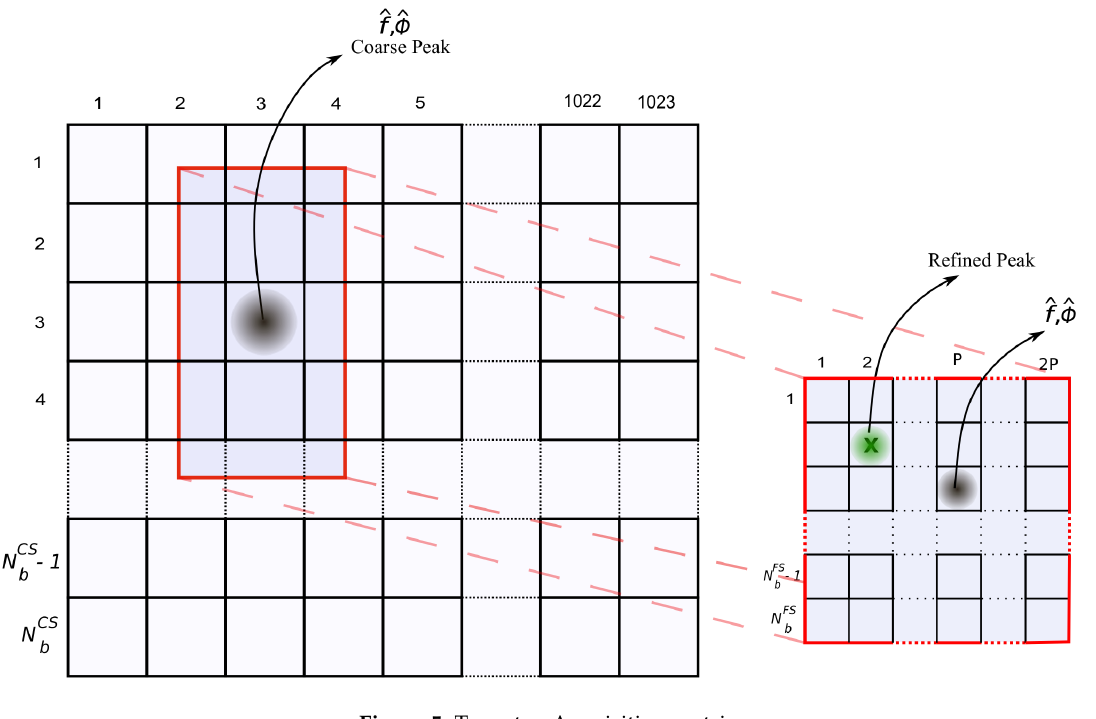
Figure 5. Two-step Acquisition matrix.